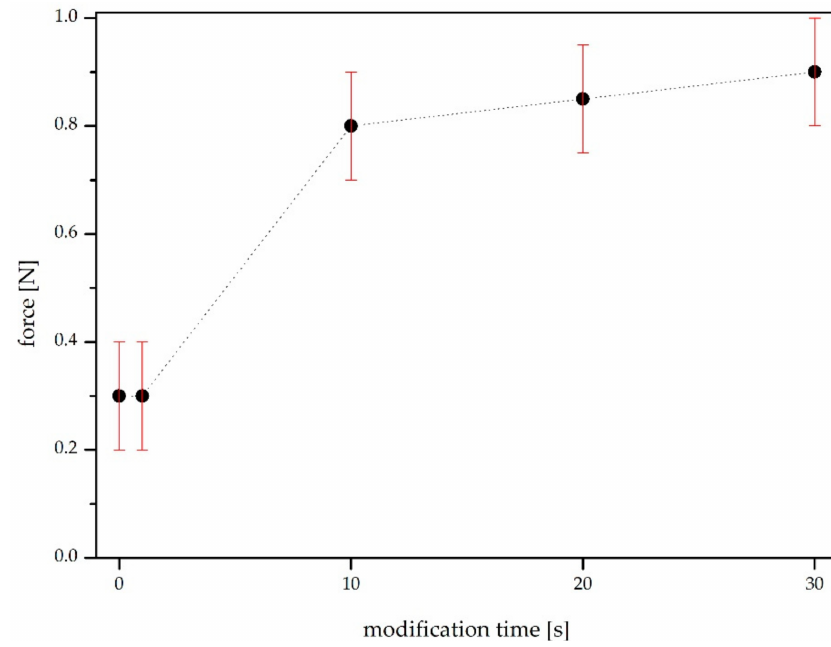
Figure 7. Force needed to detach the modified sample from the unmodified